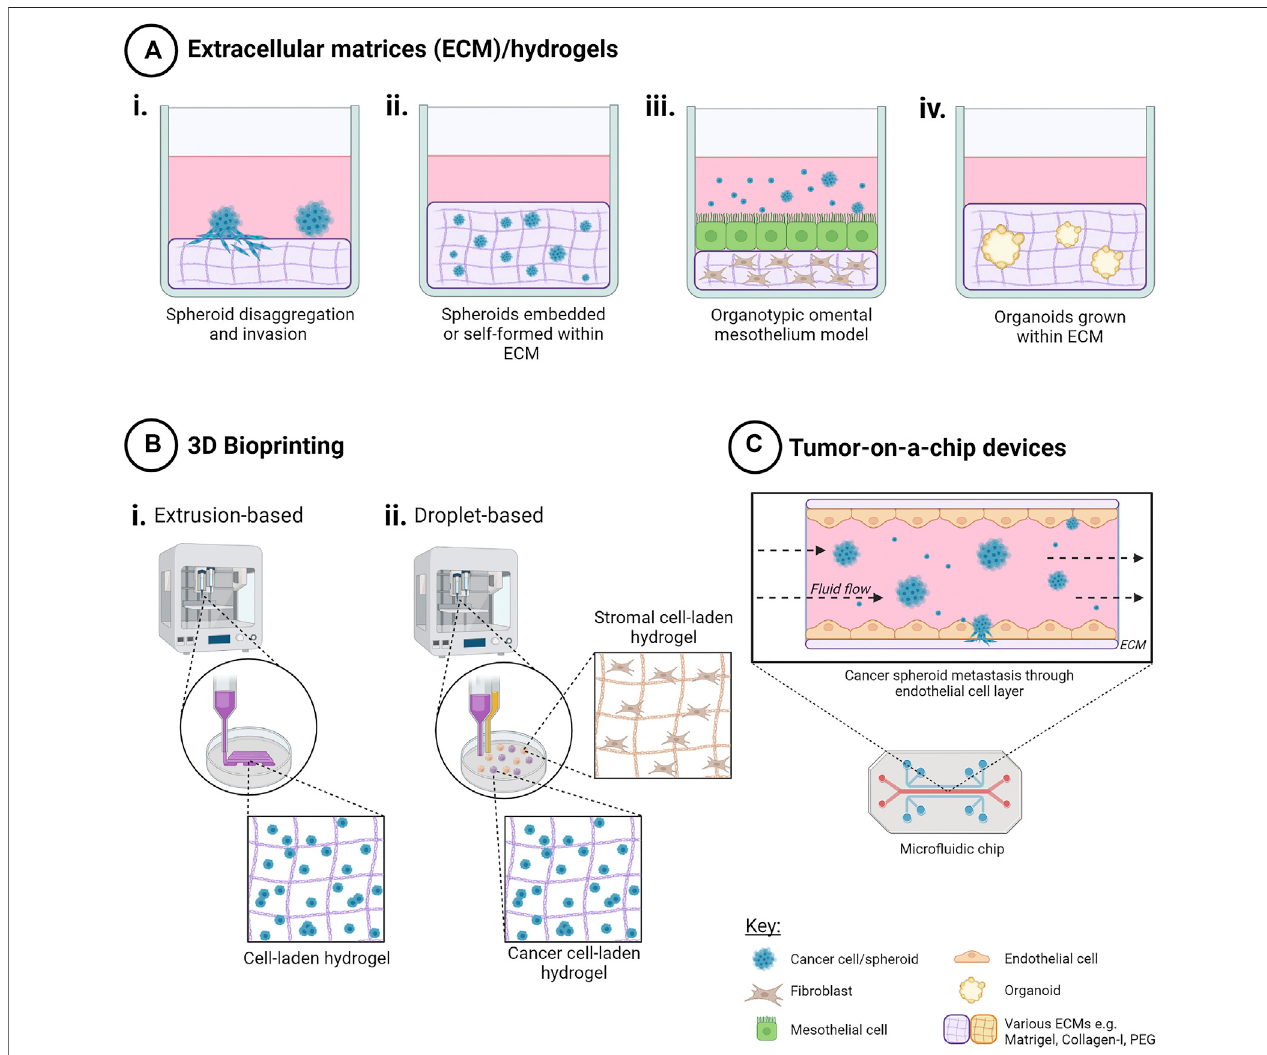
FIGURE3| Techniquestocreate3D invitro cancermodelsusingscaffolds.Additionofextracellularmatrix(ECM)asscaffoldsfor3Dcellculturesenablesbothcell- cell and cell-ECM interactions for a more physiologically relevant 3D cancer cell model. Methods include (A) ECM/hydrogels with cancer cells i) on top of, or ii) encapsulatedwithinanECM,iii)organotypicomentalco-culturemodelandiv)organoidpropagation. (B) 3Dbioprintingtechniquessuchasi)extrusion-basedbioprinting enables creation of 3D cell-laden models in hydrogels in a layer-by-layer manner, and ii) droplet-based bioprinting enabling high-throughput creation of 3D cell modelsinhydrogelswithhigherspatialcontrolformorecomplexco-culture. (C) Tumor-on-a-chip micro fl uidicdeviceshavebeenusedtomodeltheeffectsof fl uidshear stress, as well as simulating nutrient, gas and drug gradients, for ascites metastasis modelling. Created with Biorender.com.